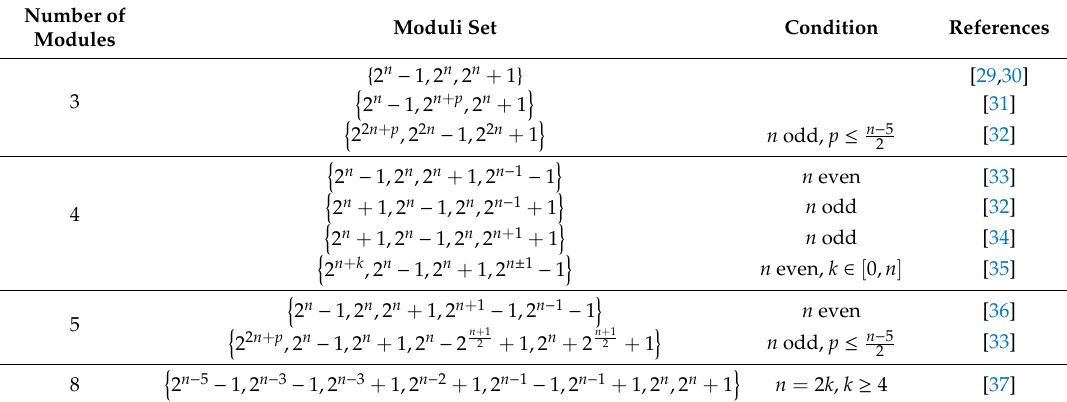
Table 1. Known balanced moduli